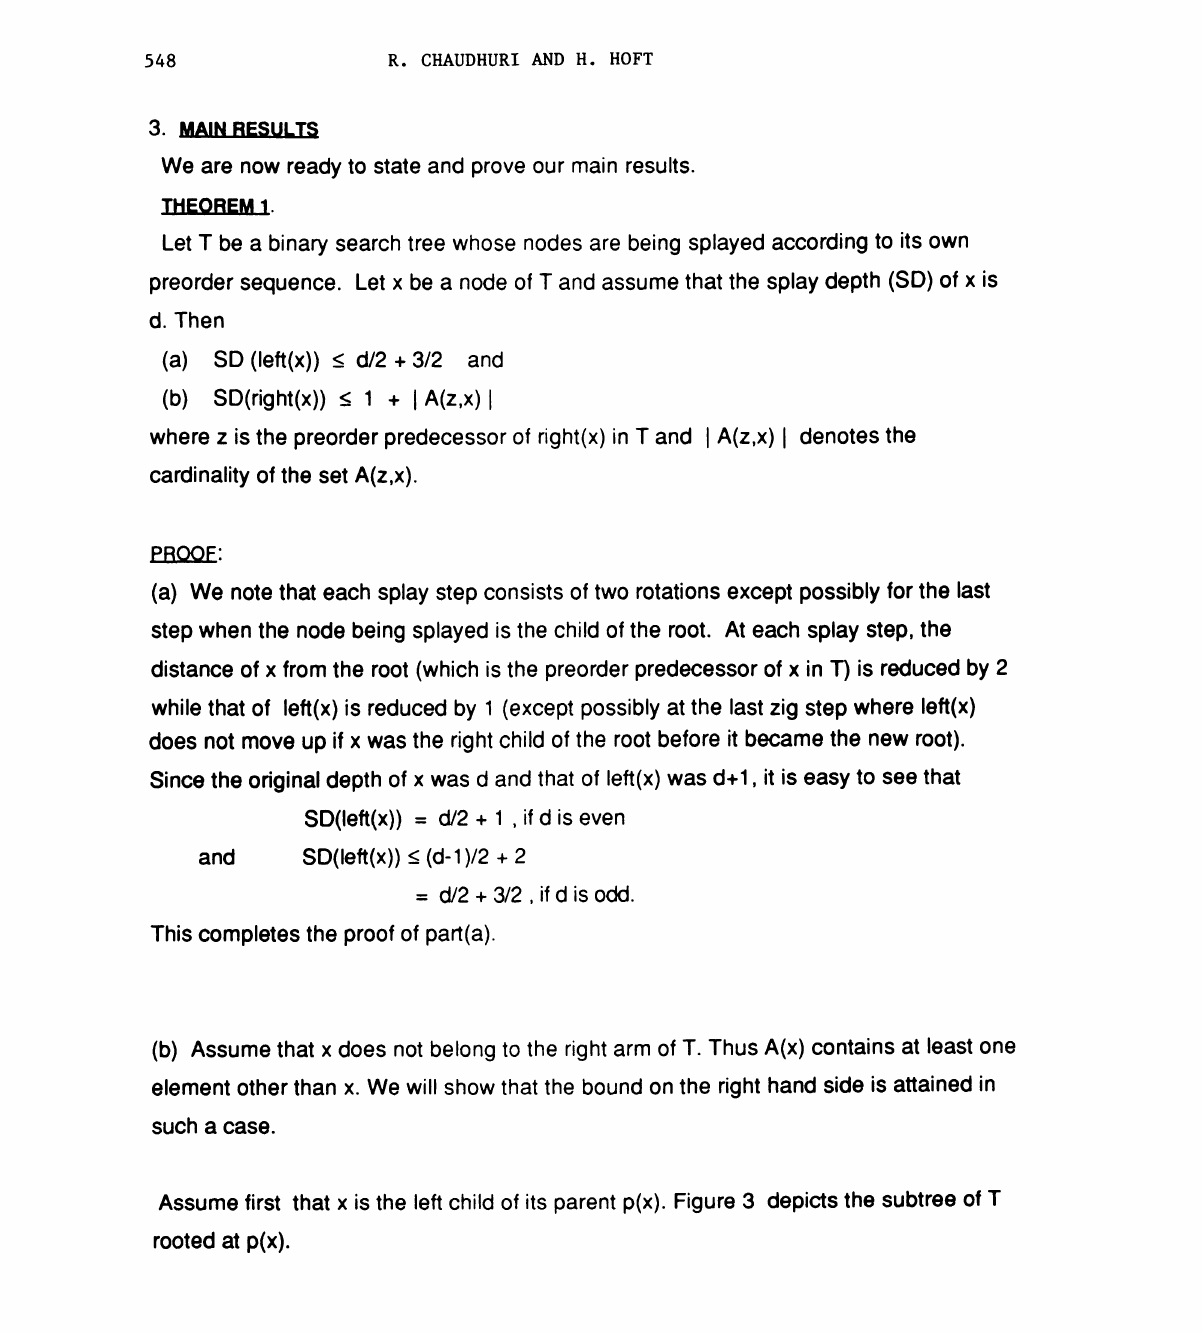
Figure 3. Subtree rooted at p(x) in the original tree